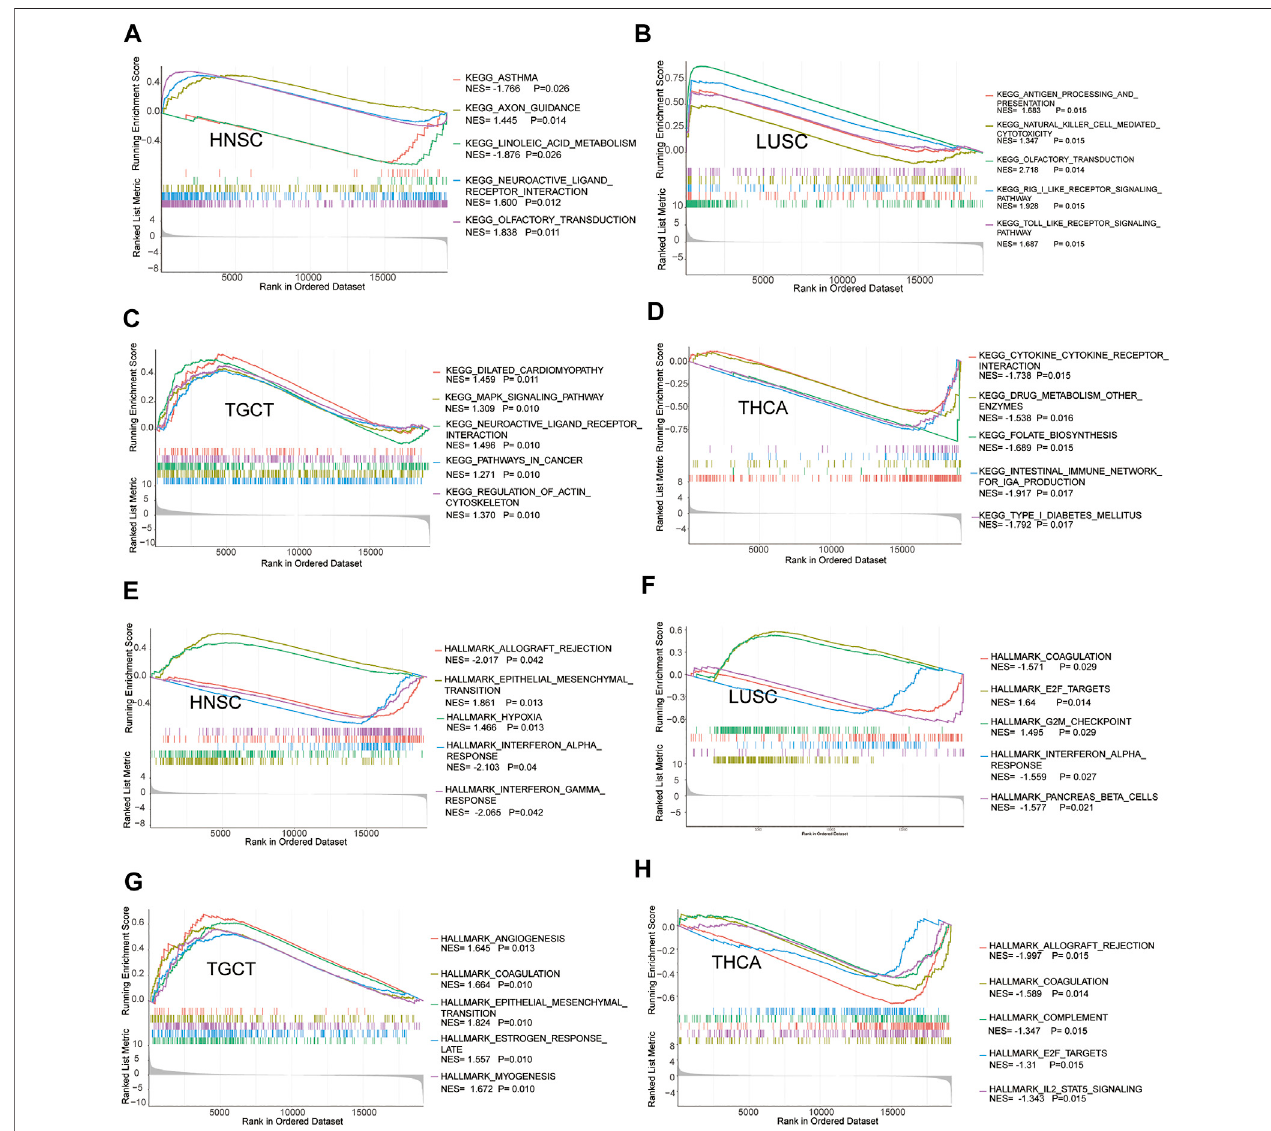
FIGURE8| GenesetenrichmentanalysisofSTC2.EnrichmentsofKEGGpathwaysinHNSC (A) ,LUSC (B) ,TGCT (C) ,andTHCA (D) .EnrichmentsofHALLMARK pathways in HNSC (E) , LUSC (F) , TGCT (G) , and THCA (H) .